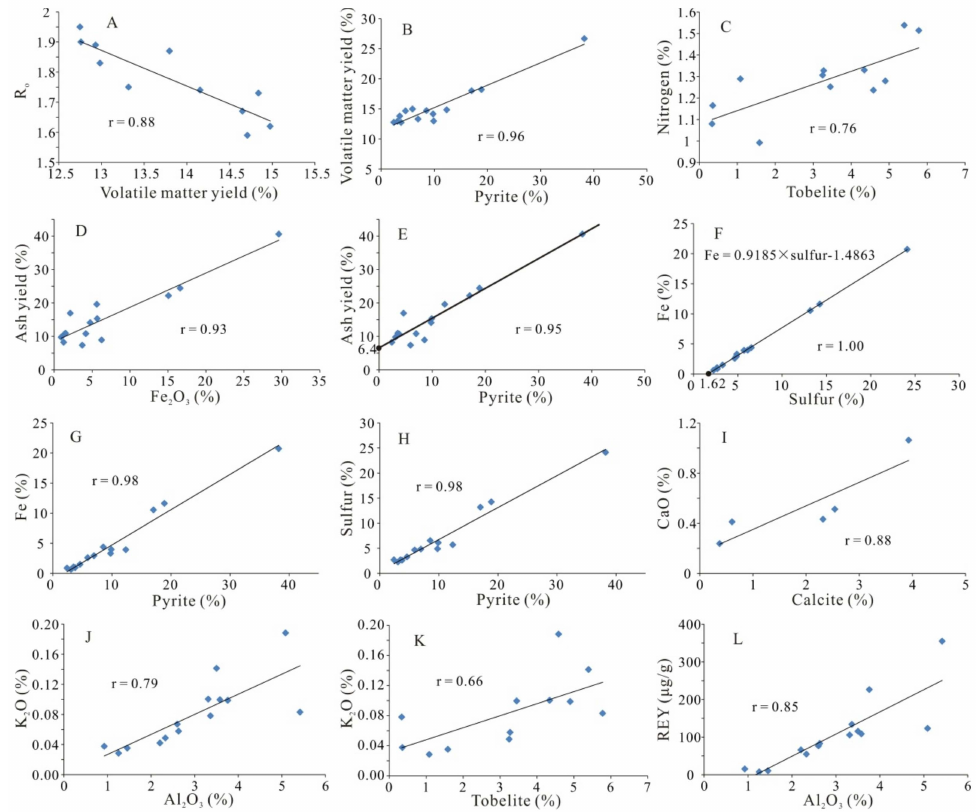
Figure 4. Correlation coe ffi cient of selected elements, minerals, volatile matter yield, ash yield, and Ro. Correlation of Ro-volatile matter yield ( A ), pyrite-volatile matter yield ( B ), tobelite-nitrogen ( C ), Fe 2 O 3 -ash yield ( D ), pyrite-ash yield ( E ), sulfur-Fe ( F ), pyrite-Fe( G ), pyrite-sulfur ( H ), calcite-CaO ( I ), Al 2 O 3 -K 2 O ( J ), tobelite-K 2 O ( K ), and Al 2 O 3 -REY ( L